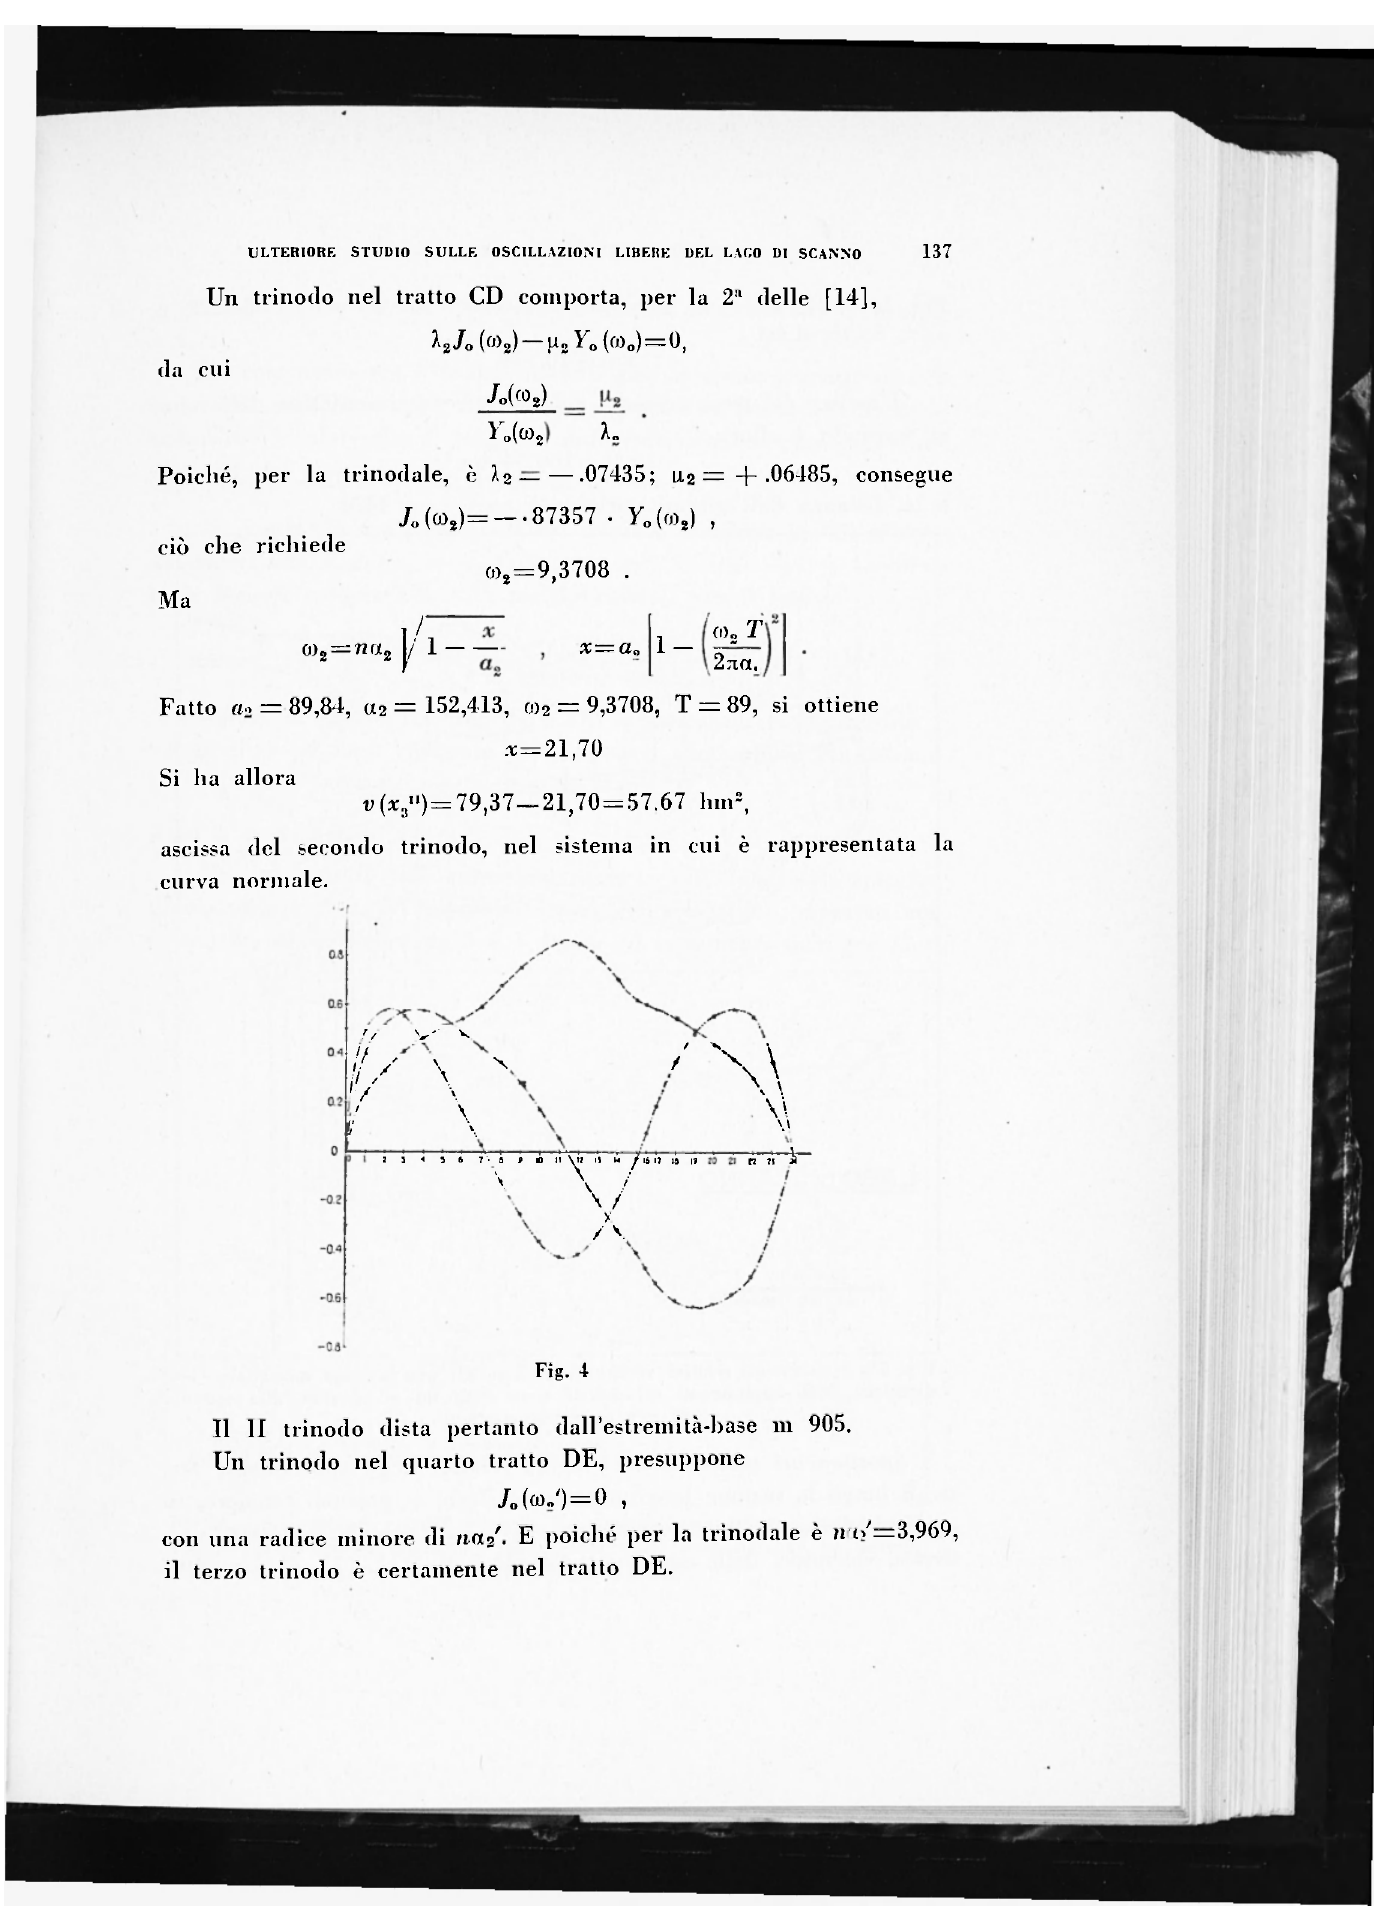
Il li trinodo dista pertanto dall'estremità-base 111 905. Un trinodo nel quarto tratto DE, presuppone /.(C0.')=O